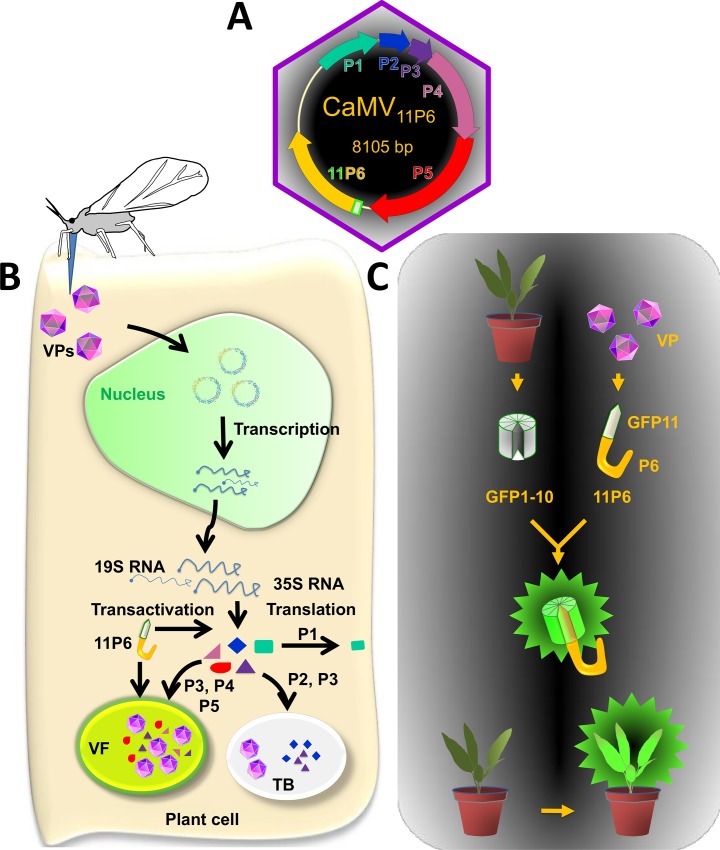
Presentation of the CaMV infection cycle and the split GFP system.(A) The circular double-stranded DNA genome (~8 kbp; circle with arrows) of CaMV is encapsidated in an icosahedral virus particle (mauve hexagon) and codes for six proteins (P1-P6, arrows) that are detected in infected plants. The GFP11 tag (grey box with green border) is fused to the P6 coding sequence yielding 11P6. (B) The infection cycle starts with virus particles (VPs) being delivered into the cytoplasm of a plant cell after it has been punctured by the stylets of an aphid vector. VPs dock at the nuclear envelope and disassemble to allow the naked viral DNA to enter the nucleus. There, the viral genome is transcribed to produce two mRNAs, the 19S RNA encoding P6, and the pregenomic, polycistronic 35S RNA encoding also the other viral proteins. P6 belongs to the early proteins that are translated in the cytoplasm (note that P6 has been replaced by 11P6 in this study). Within the cytoplasm, P6 accumulates in foci that will give rise to the virus factories [here is exemplified one (VF)] with P6 forming the matrix protein, where all viral synthesis occurs and most progeny VPs are stored. Viral synthesis in the VFs involves many coordinated events including the P6-mediated translation transactivation required for the translation of all viral proteins from the polycistronic 35S RNA. The translation products include P1 or MP, the movement protein that associates with the plasmodesmata and is required for cell-to-cell and systemic movement of the virus; P2 or ATF, the aphid transmission factor that binds the virus particles to the aphid vector mouthparts during plant-to-plant transmission; P3 or VAP, the virus-associated protein, P4 or CP (capsid protein), and P5 or RT, the reverse transcriptase generating progeny DNA genomes from the 35S RNA. P6 or TAV (transactivator-viroplasmin) is, besides a transactivator and VF matrix protein, an RNA silencing suppressor that interferes with specific anti-viral defense pathways. Because CaMV engineered to express 11P6 is infectious (as demonstrated in this study), 11P6 is presumed to be functional in all the above stated P6 activities. Besides VFs, a second type of viral inclusions, the transmission bodies (TBs), forms during infection. TBs contain P2, P3 and some VPs and are entirely dedicated to aphid transmission. (C) The split GFP system used in this study. The transgenic reporter plant (top left) expresses the non-fluorescent GFP1-10 (gray barrel with green outline). When infected with CaMV11P6, 11P6 produced during infection associates with GFP1-10, yielding fluorescent GFP1-10/11P6 complexes (green barrel) that can be observed by real time fluorescence microscopy or macroscopy. The aphid drawing in (A) is from [24].